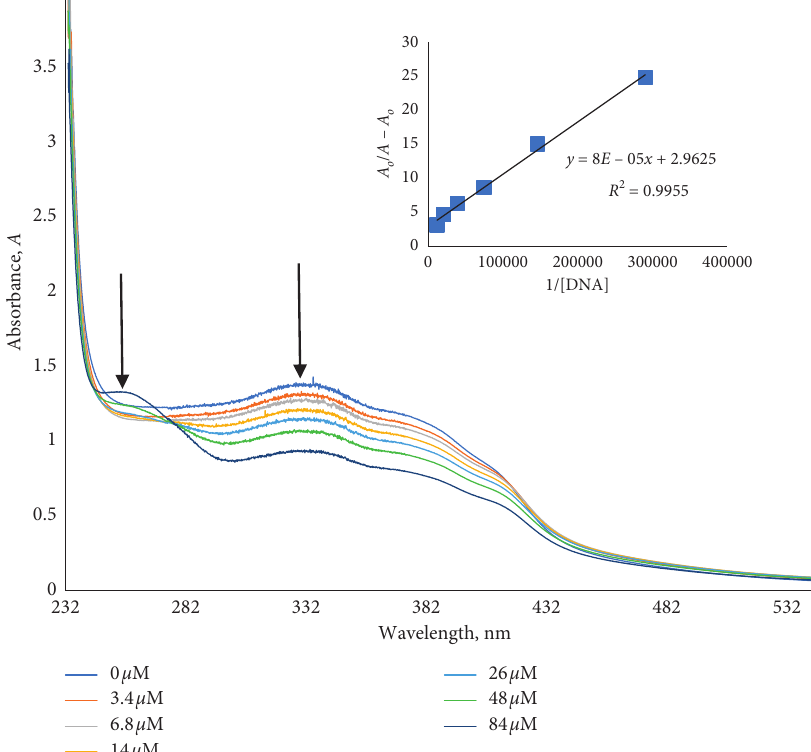
Figure 10: UV-visible absorption spectra for the C1 at 18 µ M without CT-DNA and with serial addition of DNA. Inset is the Bene- si–Hildebrand plots for the determination of binding